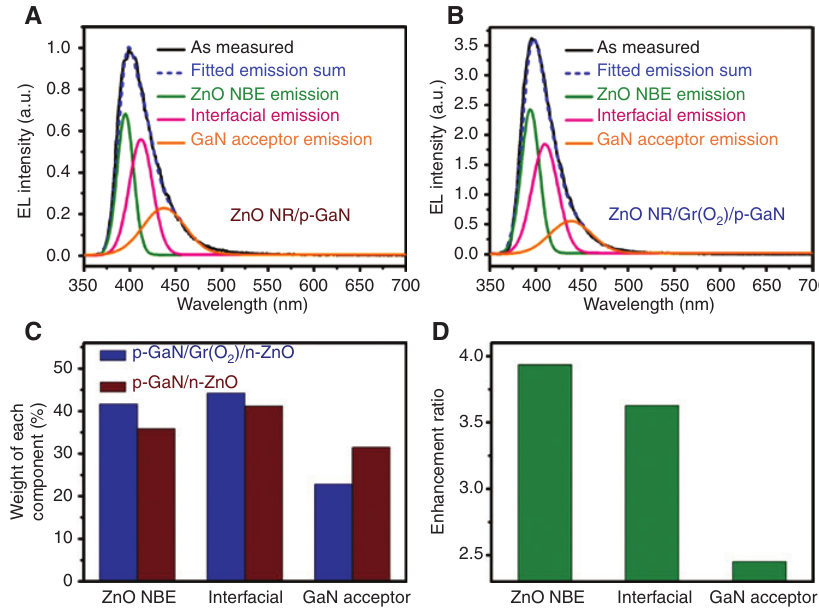
Figure 6: The luminescence sources in EL spectra. Gaussian deconvolution fittings of EL spectra in LEDs without (A) and with (B) a graphene plasmon layer. (C) Weight distribution of every luminescence component. (D) Enhancement ratio of every luminescence